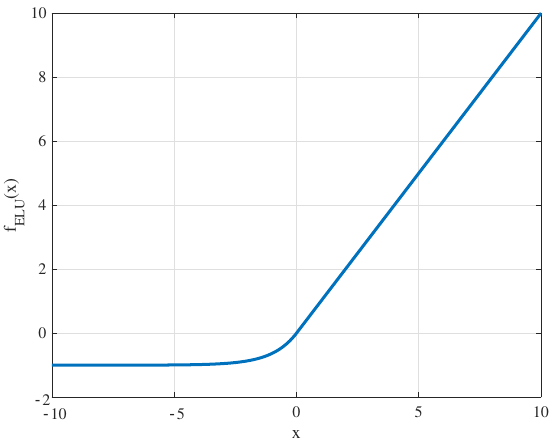
Figure 4. The exponential linear unit (ELU) activation